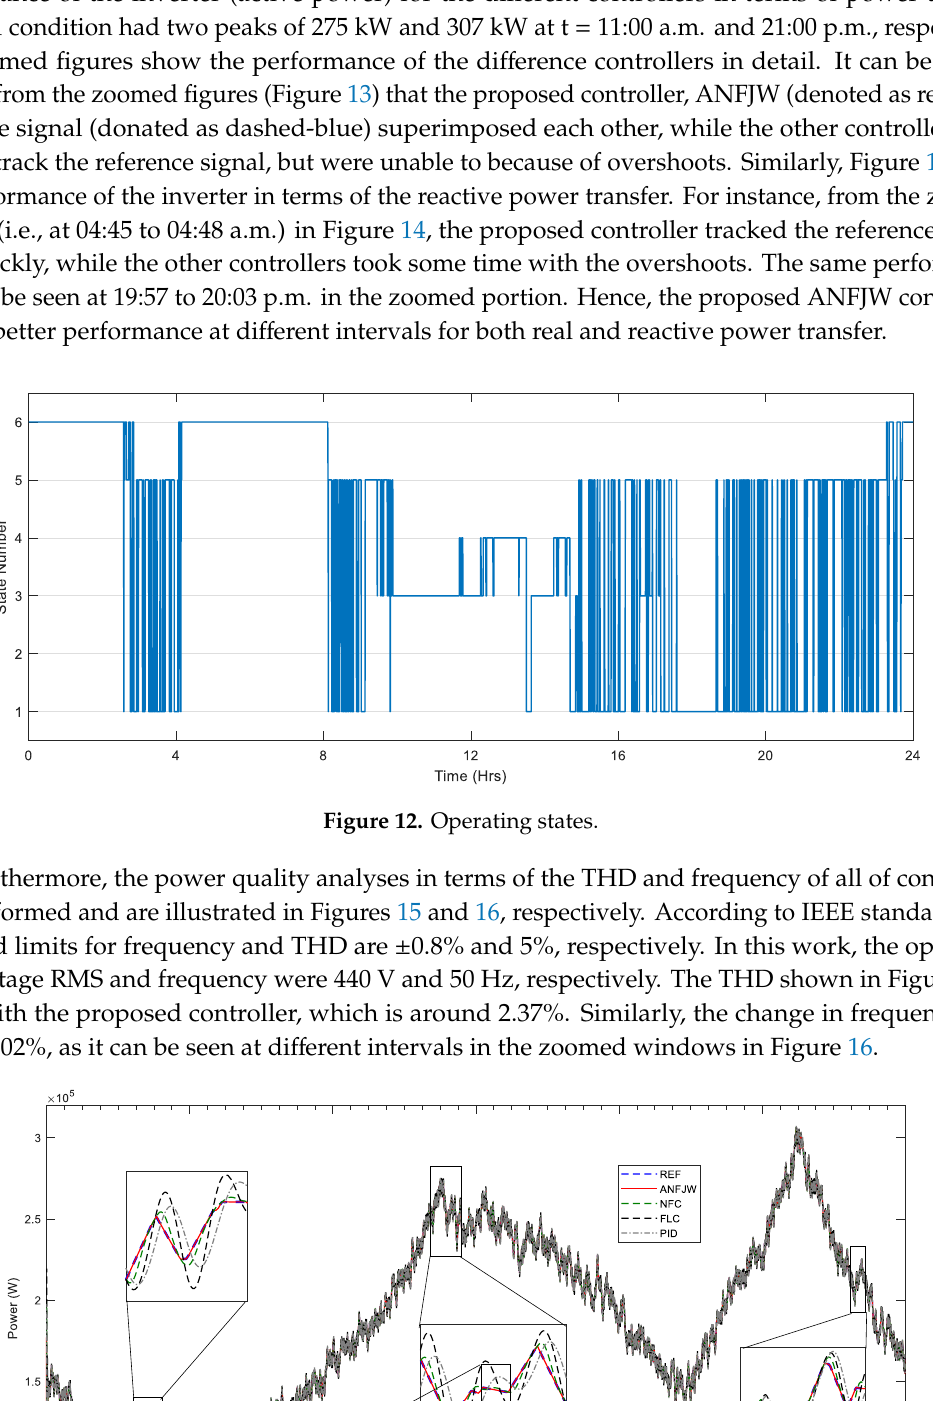
Figure 11. States of charge (SoCs) of the ultra-capacitor (UC) and battery.